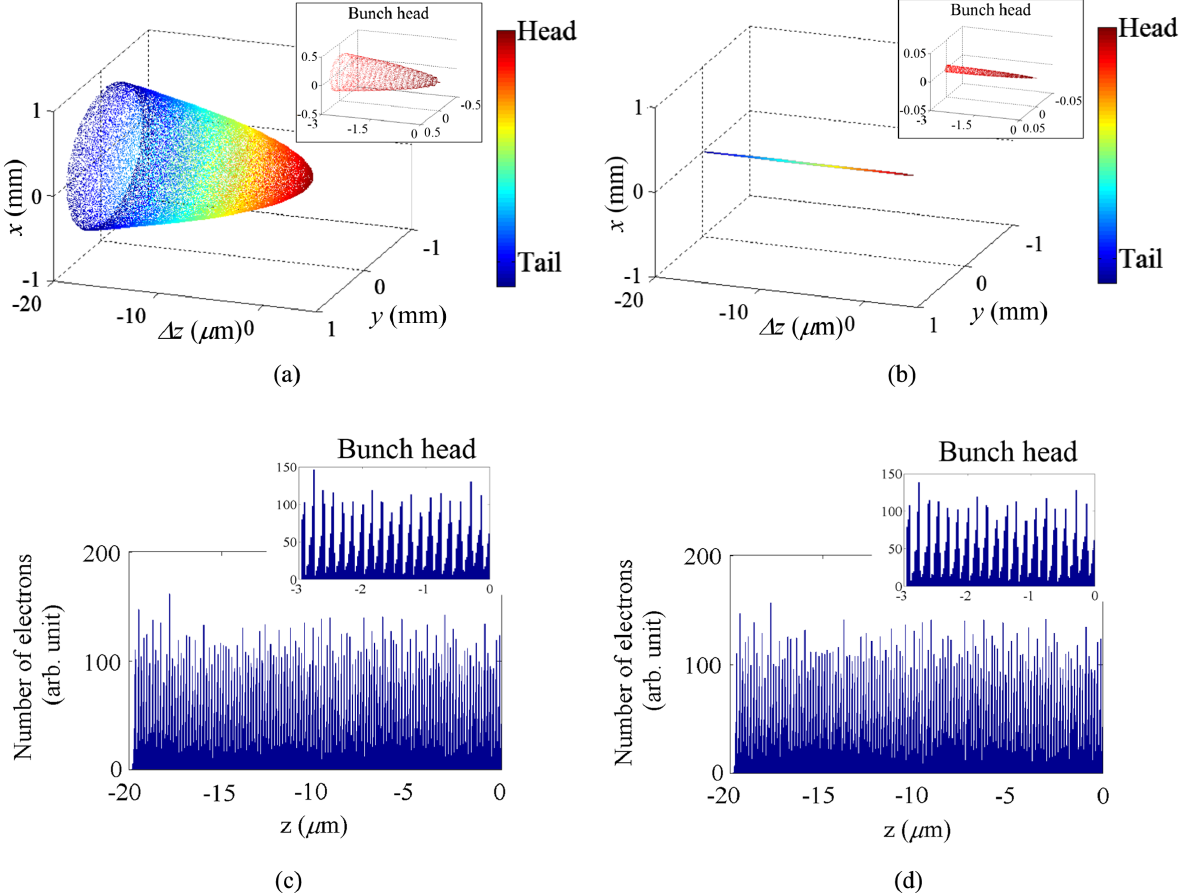
FIG. 8. Spatial distributions of the hollow structured beam at the (a) exit of the rf accelerator system ( z ¼ 23 m) and (b) focal point of the electron beam ( z ¼ 55 m). Longitudinal distributions of the beam at (c) z ¼ 23 m and (d) z ¼ 55 m. The subplot show the zoom-in views near the bunch